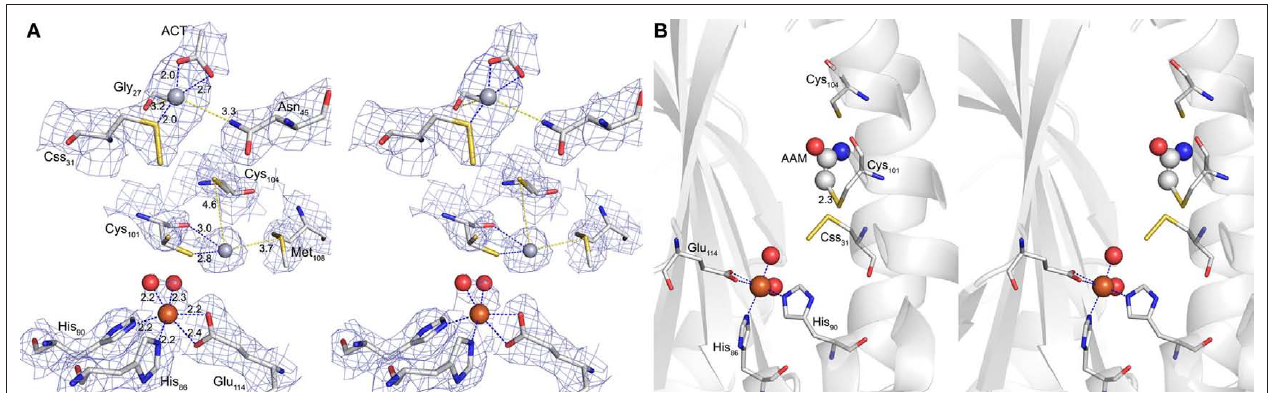
Cys FiguRe 7 | hg 2 + and iodoacetamide-binding sites. (A) Electron density at the and to S δ of Met (yellow dashed lines); Fe 3 + with two water ligands (red 104 108 Hg 2 + -binding sites (blue mesh representing 2m|Fo| − D|Fc| map at 1 σ ). spheres), two histidine side chains and a bidentate glutamate (all blue dashed lines); sticks representation: carbon in gray, nitrogen in blue, sulfur in yellow and Cross-eyes stereo image of the coordination spheres of the two Hg 2 + ions (gray oxygen in red; ACT, acetate. (B) Cross-eyes stereo image of the acetamide spheres) and the active site Fe 3 + (brown sphere); Hg1 at S γ of Css with 31 (AAM) binding site with secondary structure representation of the subunit additional distances to one acetate (ACT) and the backbone oxygen of Gly (blue 27 backbone; Fe site and sticks representation as above; AAM in sticks dashed lines) and to N δ of Asn (yellow dashed line); Hg2 at S γ and the 45 and backbone oxygen of Cys (blue dashed lines) and with the distances to S γ of 101